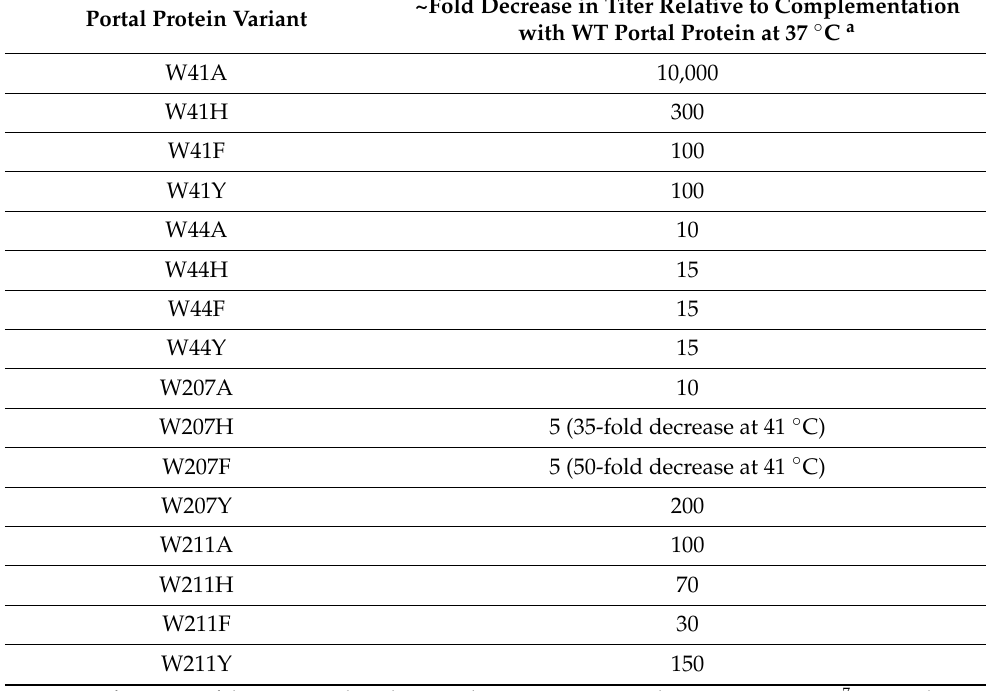
Table 1. Relative efficiency of plating of trp to ala, his, phe and tyr portal protein variants. ~Fold Decrease in Titer Relative to Portal Protein Variant